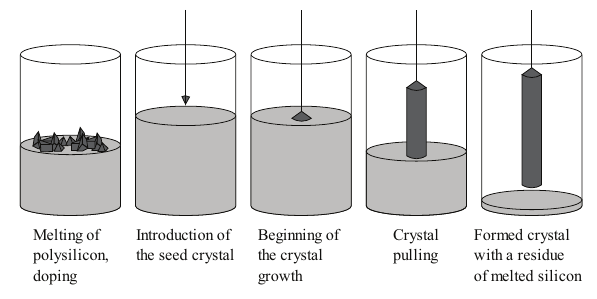
Figure 1: The main batch steps of the CZ process. Il- lustration from Wikipedia (the illustration is released to public domain by the copyright